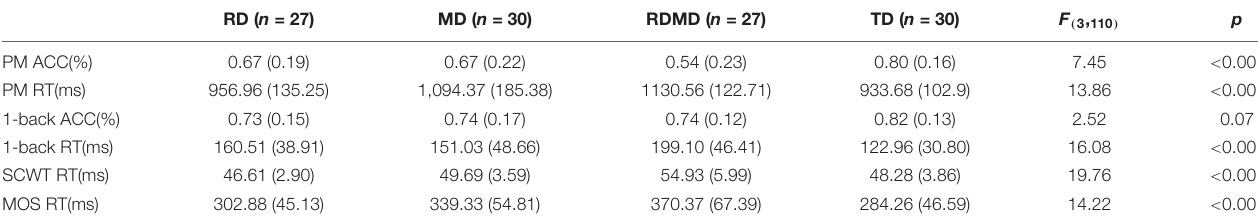
TABLE 2 | Comparison of performances on the PM task and N-back, SCWT, and More-odd shifting tasks for the four groups.